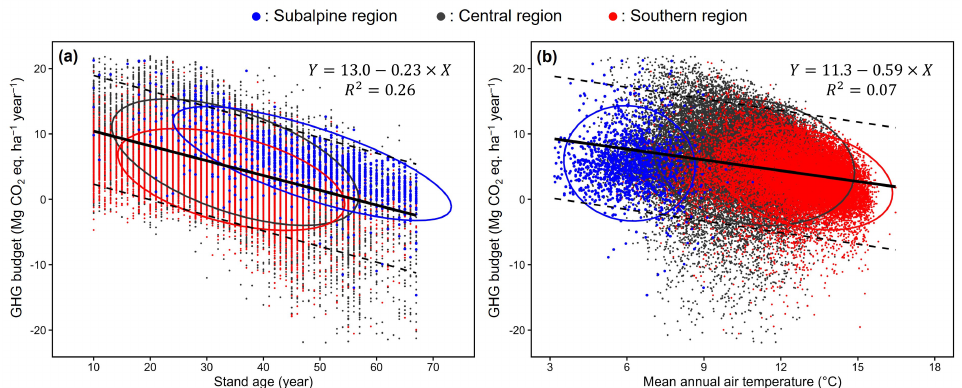
Figure 4. Bivariate relationships between both ( a ) stand age and ( b ) mean annual air temperature in 2021 and GHG budget for 2021 under the current climate. A dot indicates each result of the whole simulation unit of 59,939. Black solid lines are linear relationships between two variables for the whole simulation unit ( p < 0.05). Black dashed lines are 95% prediction intervals. An ellipse indicates a 95% confidence level for each region’s bivariate